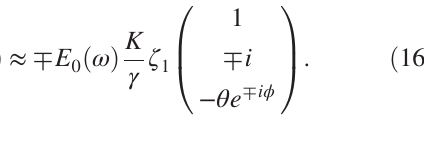
FIG. 1. Constant phase contours for second harmonic emission from (a) left-handed undulator (LHU) and (b) right-handed undulator (RHU). Also indicated are the corresponding projec- ˆ ˆ L S tions of spin and angular momentum for the electromag- z z netic fields, which point in the same direction as the classical orbital angular momentum of the electrons on their helical trajectory through the